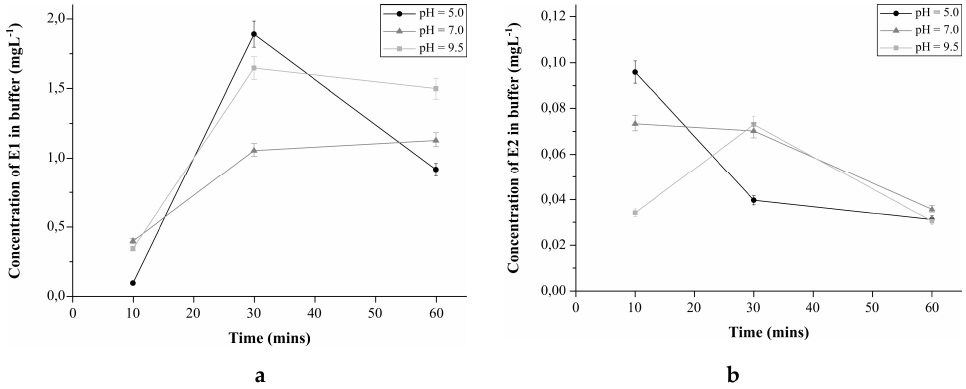
Figure 8. ( a ) The E1 release curve with E1-mag-MIP in solutions with different pH values: 5.0, 7.0, and 9.5. ( b ) The E2 release curve with E2-mag-MIP in solutions with different pH values: 5.0, 7.0, and 9.5.